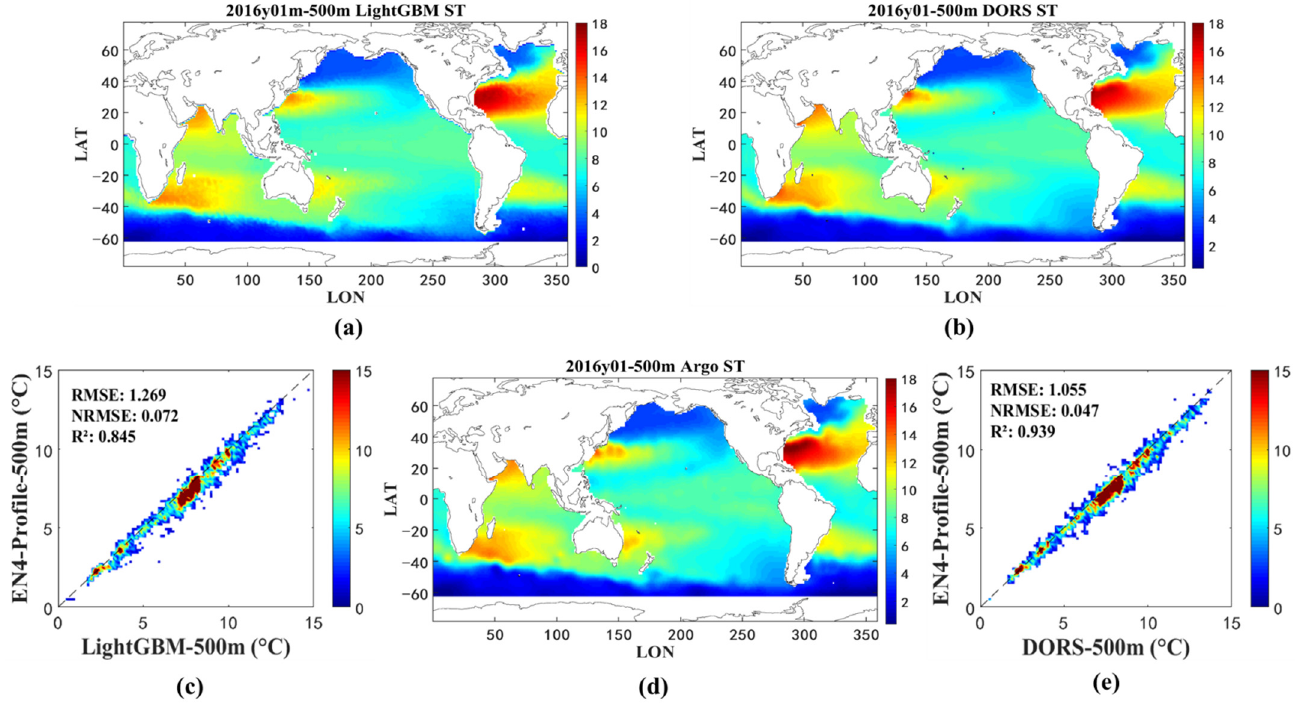
Figure 6. The spatial distribution of DORS, LightGBM, and Argo at 500 m for January 2016, and intensity scatter plots: ( a ) is the LightGBM ST, ( b ) is the DORS ST, ( c ) is the intensity scatter plots between the LightGBM ST and the EN4-Profile ST, ( d ) is the Argo ST, and ( e ) is the intensity scatter plots between the DORS ST and the EN4-Profile ST.